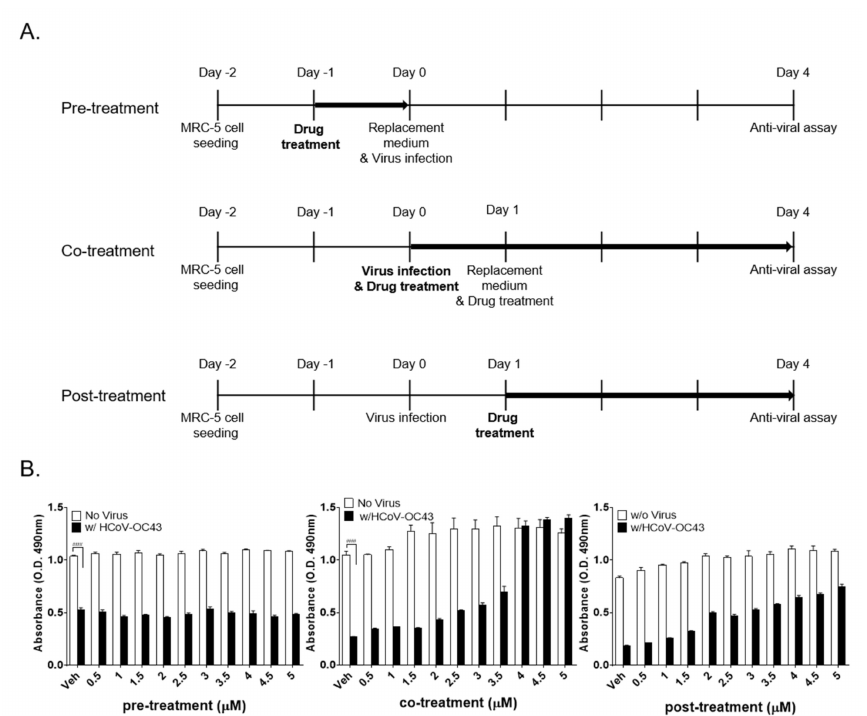
Figure 3. Time-of-addition assay to evaluate the impact of kurarinone. ( A ) Overall scheme for time-of-addition assay. The bold arrows denote the duration of kurarinone treatment. Kurarinone